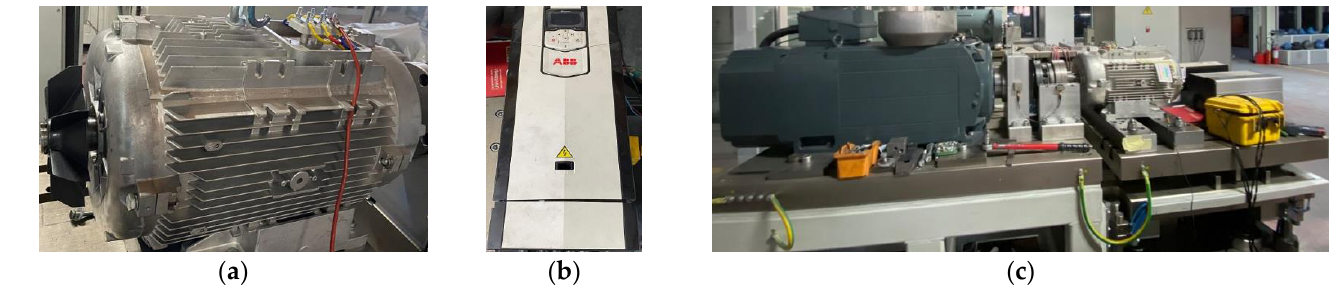
Figure 7. Experimental setup: ( a ) Manufactured SynRM; ( b ) Driver; ( c ) Test system.